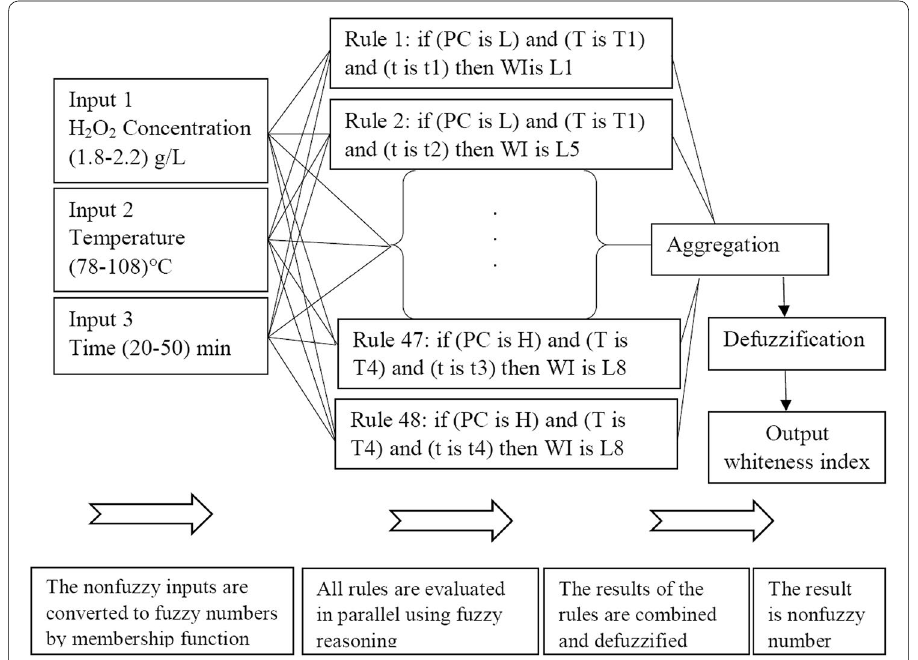
Fig. 6 Schematic diagram of fuzzy modelling for predicting whiteness